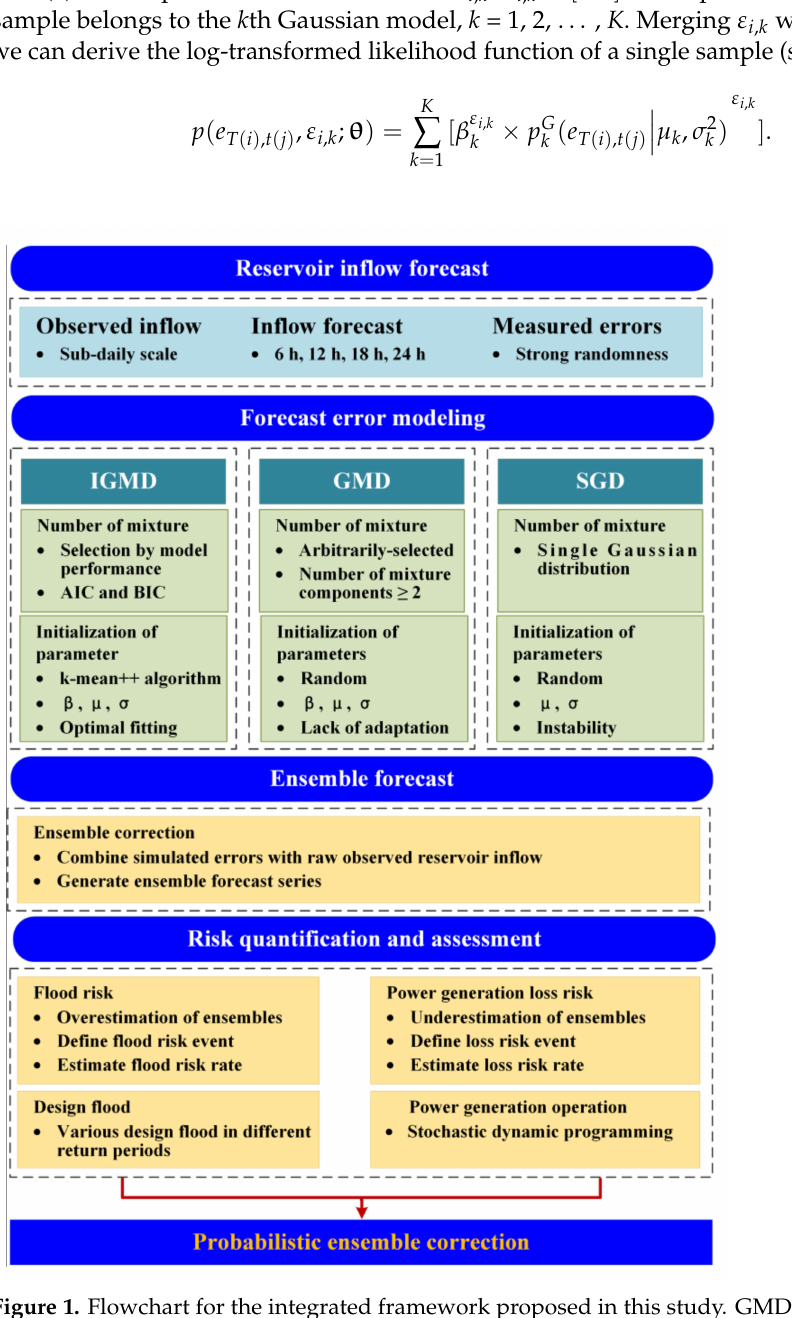
Figure 1. Flowchart for the integrated framework proposed in this study. GMD, IGMD, and SGD denote the Gaussian mixture distribution, the improved Gaussian mixture distribution, and the single Gaussian distribution models, respectively. Note that the IGMD was the model proposed in this study and was used to quantify the inflow forecast uncertainty (IFU) and flood risk, as well as the electricity curtailment risk, while the GMD and SGD were used for comparison with the IGMD. AIC: Akaike information criterion, BIC: Bayesian information